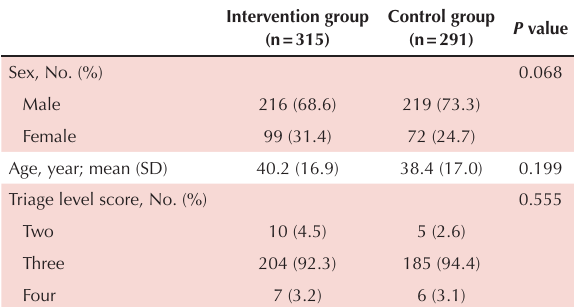
Table 1: The distribution of sex, age and triage level between the intervention and control group Intervention group (n =